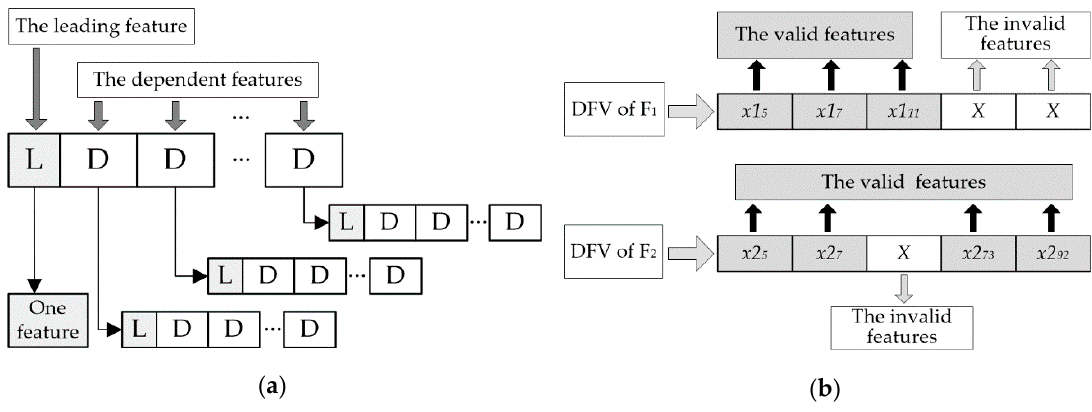
Figure 2. ( a ) The structure of DFV; ( b ) the valid and invalid features of DFV .